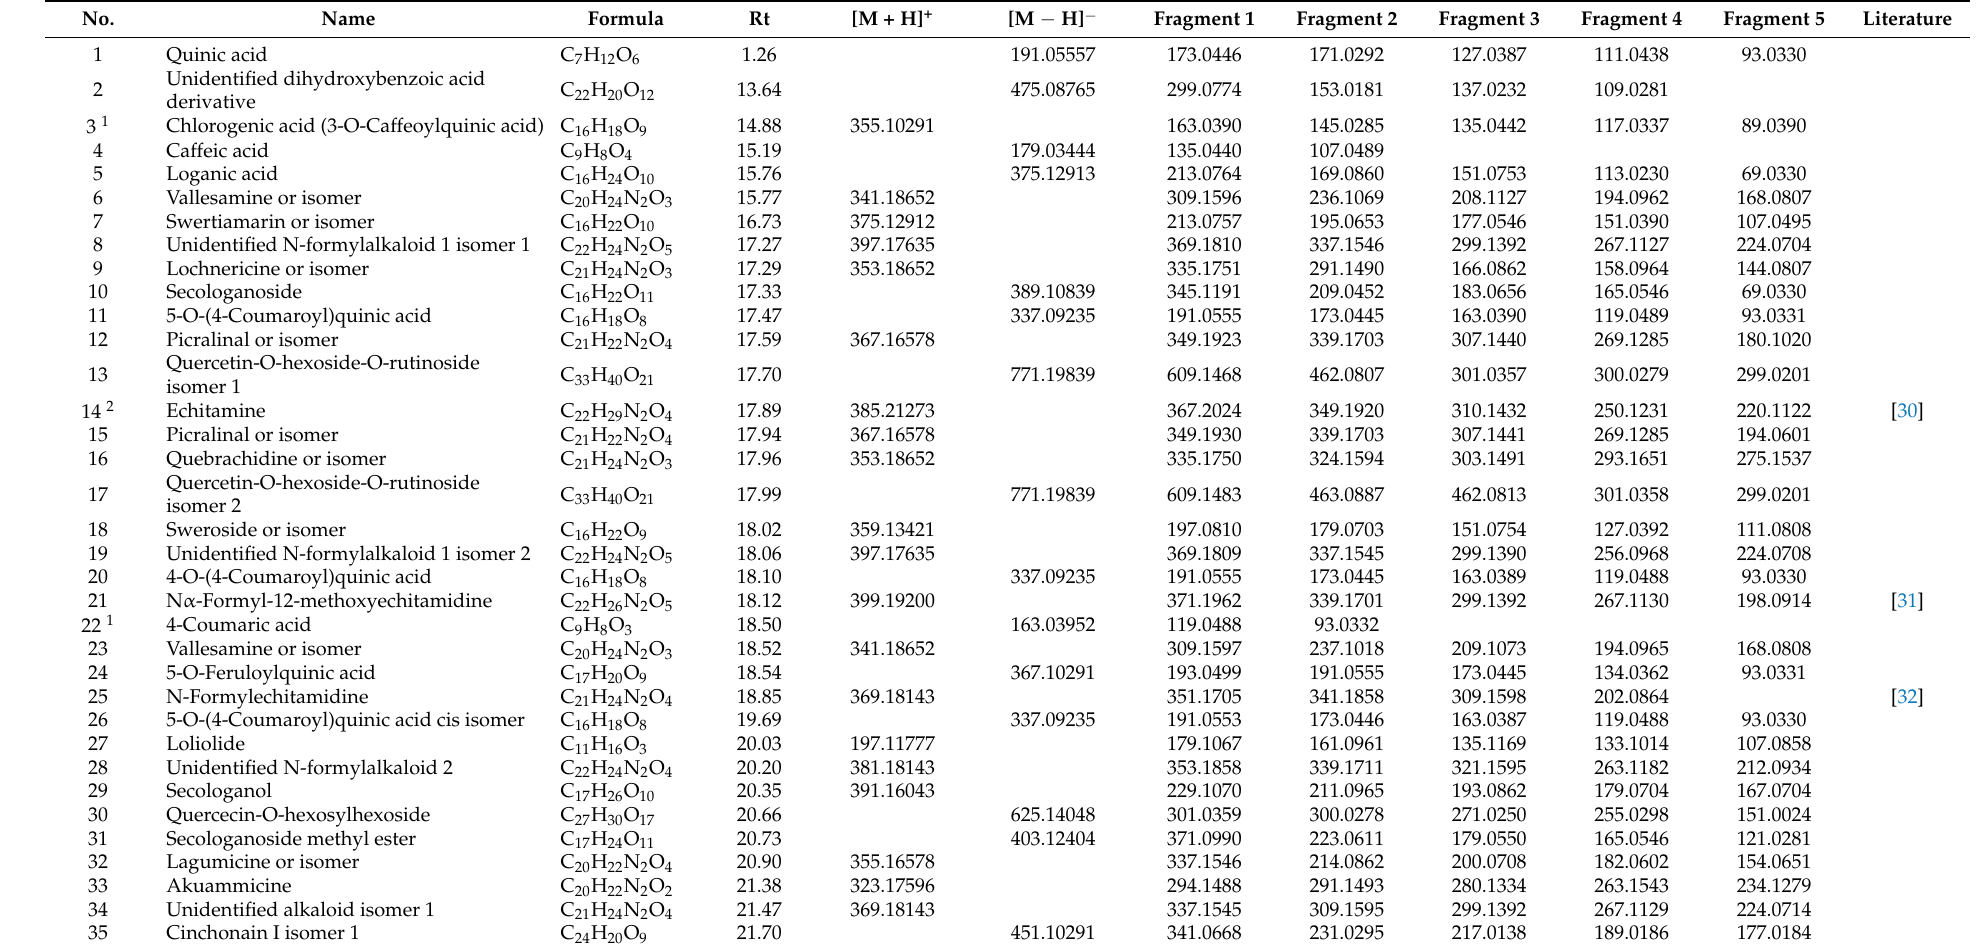
Table 4. Chemical characterization of leaves—MAC-MeOH (not